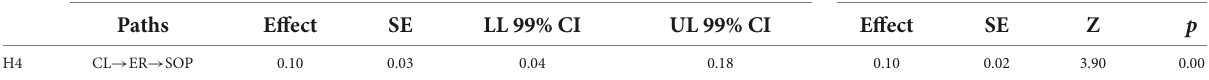
TABLE 7 Results of mediation